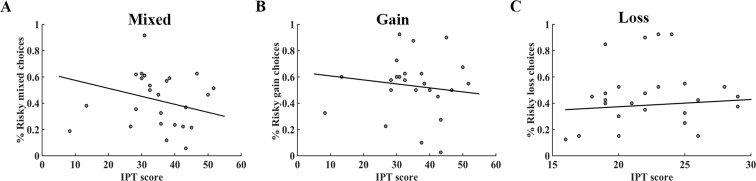
The relationship between IPT score and the percentage of risky choices in the fMRI dataset.The IPT score was not correlated with the percentage of risky choices in the (A) mixed trials (r = −0.270, p = 0.202), (B) gain trials (r = −0.119, p = 0.580) nor (C) loss trials (r = 0.201, p = 0.347). The r and p values reported here were obtained after controlling for GPT scores as a covariate of no interest. GPT, greed personality trait; IPT, impulsivity personality trait.